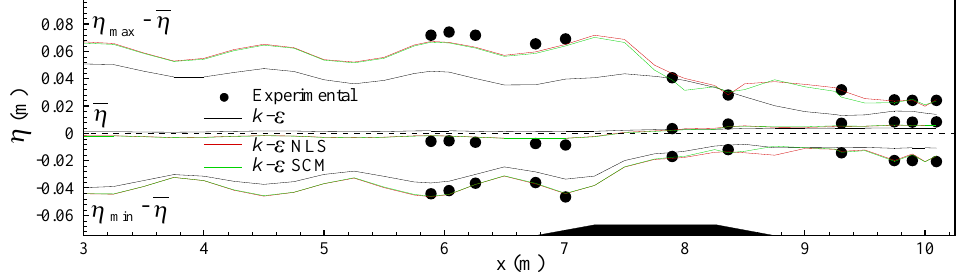
Figure 17. Maximum and minimum wave height envelopes and mean water level of k- ε , k- ε NLS and k- ε SCM models and the experiment (dash line indicates the still water level), T = 1.6 s, H = 0.10 m.